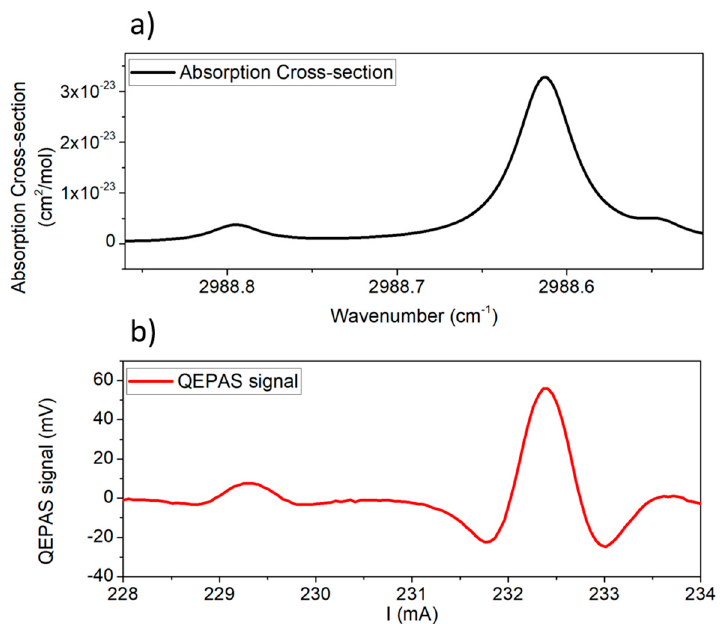
Figure 2. ( a ) Absorption spectrum of standard air simulated with HITRAN database at 200 Torr and room temperature; ( b ) QEPAS spectral scan of laboratory ambient air at 200 Torr.